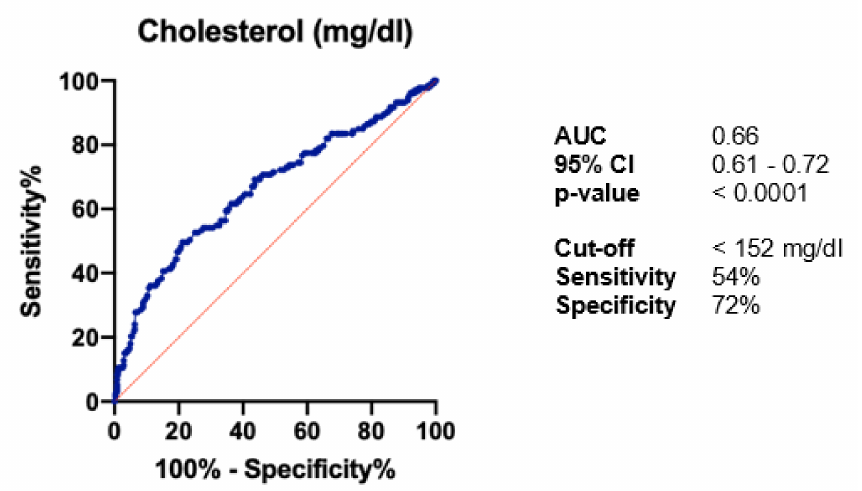
Figure 1. ROC analysis of cholesterol in the whole study population. AUC: area under the curve; CI: confidence